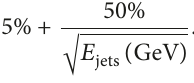
1.2%–1.76%. The missing transverse energy ( (cid:2) 𝐸 푇 ) and scalar transverse energy sum ( 𝐻 푇 ) for signal (for 𝑐 퐻푊 = 0.05) and all relevant background processes versus 𝑀 푏,푏 are shown in Figure 4. (iii) The missing transverse energy is required to be (cid:2) 𝐸 푇 > 30 GeV to suppress the backgrounds at low missing energy region. (iv) In particular, to reduce 𝑡𝑡